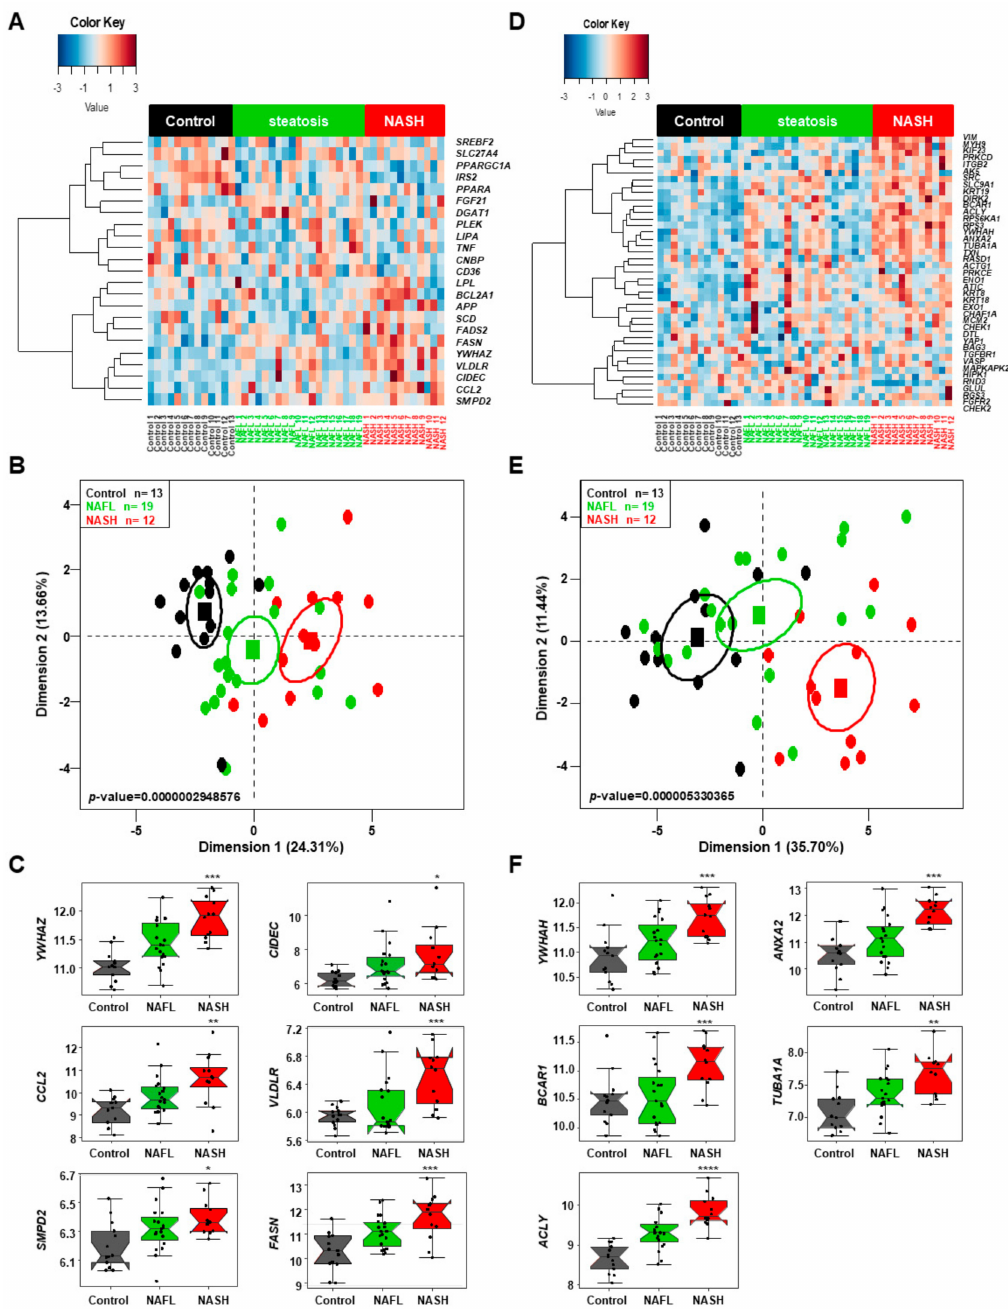
Figure 8. The NASH canonical pathway confirmed by independent Illumina gene expression beadchip. ( A ) Heatmap, ( B ) principal component analysis (PCA) and ( C ) boxplots of the main genes discriminating the three groups of patients of the PCA ( B ) based on the 25 genes of the canonical pathway applied to independent Illumina gene expression beadchip. ( D ) Heatmap, ( E ) principal component analysis (PCA) and ( F ) boxplots of the main genes discriminating the three groups of patients of the PCA (E) based on the 44 genes partners of the YWHAZ proteins linked to the canonical pathway applied to independent Illumina HumanWG-6 v3.0 gene expression beadchip (GSE33814) [65]. The groups of healthy control ( n = 13), nonalcoholic fatty liver (NAFL, n = 19) and nonalcoholic steatohepatitis (NASH, n = 12) patients are significantly di ff erent: * p < 0.05; ** p < 0.01, *** p < 0.005, **** p < 0.0005 based on ANOVA-one-way